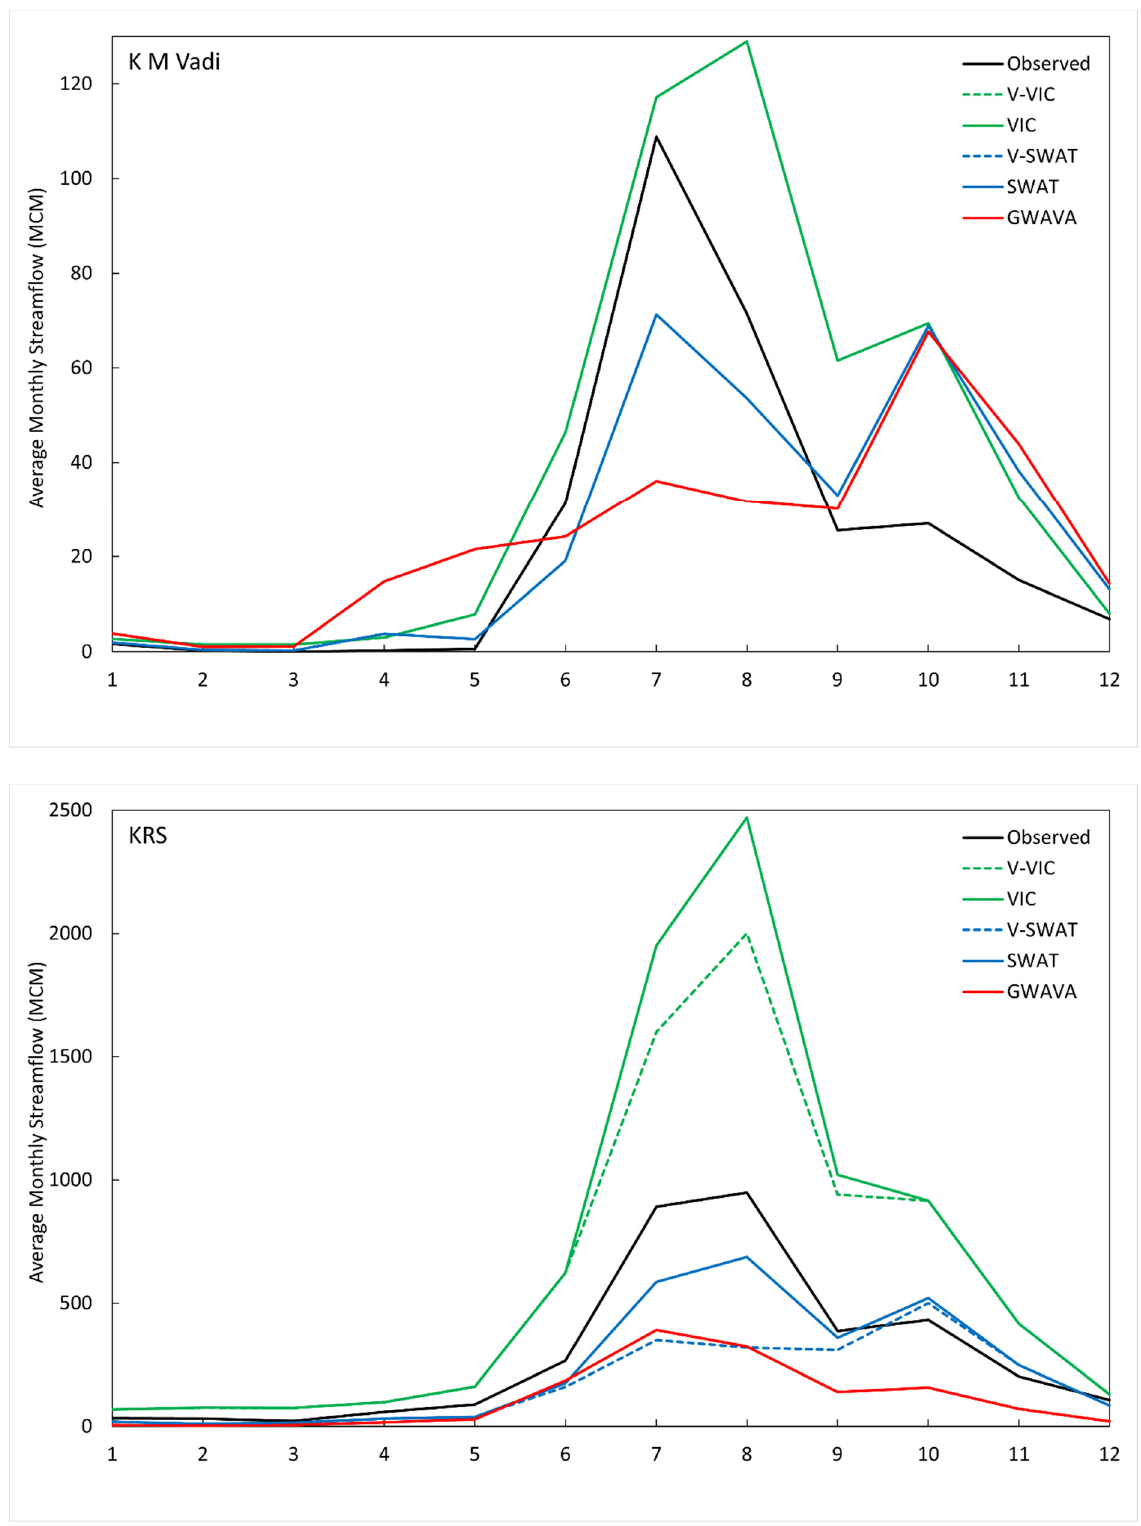
Figure A1. Monthly average streamflow in million cubic meters (MCM) for each catchment simulated by V-VIC, VIC, V-SWAT, SWAT and GWAVA superimposed with the monthly average observed streamflow.